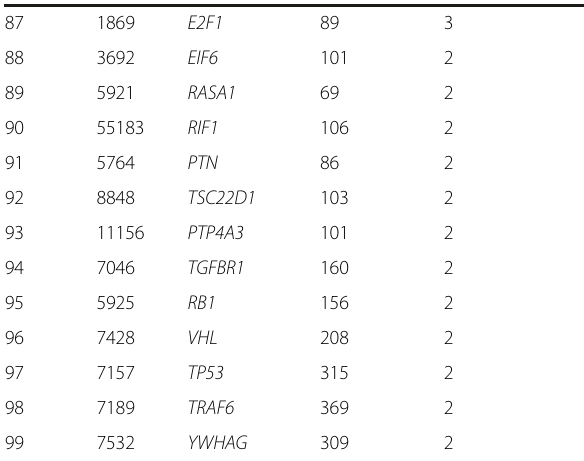
Table 3 Top-ranking non-query genes whose encoded proteins interact with 64 core